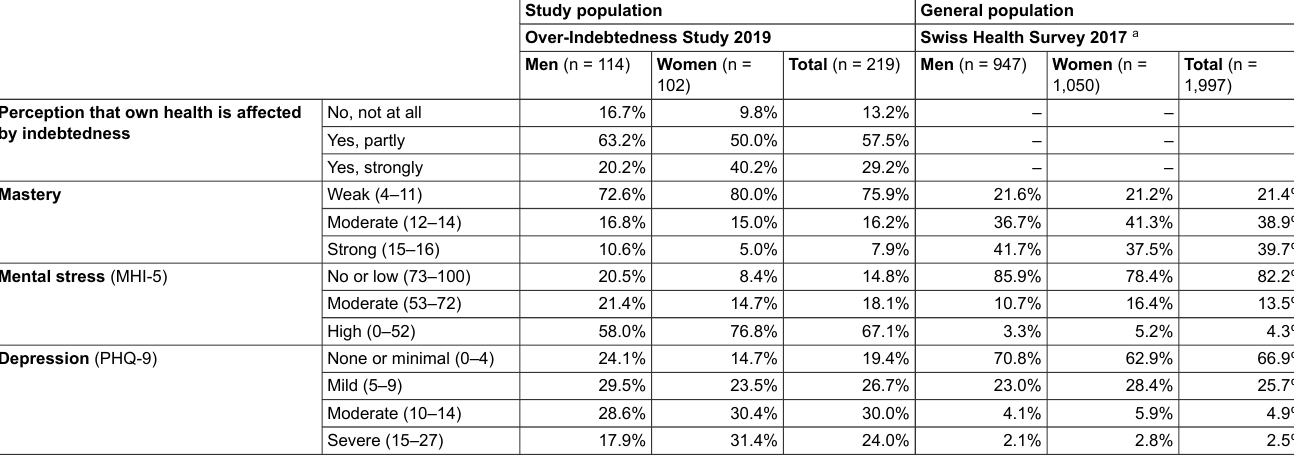
Table 2: Health-related risk factors or resources and mental health status of the study population (n = 219) stratified by sex and compared to the general adult population of the canton of Zurich (n = 1,997).